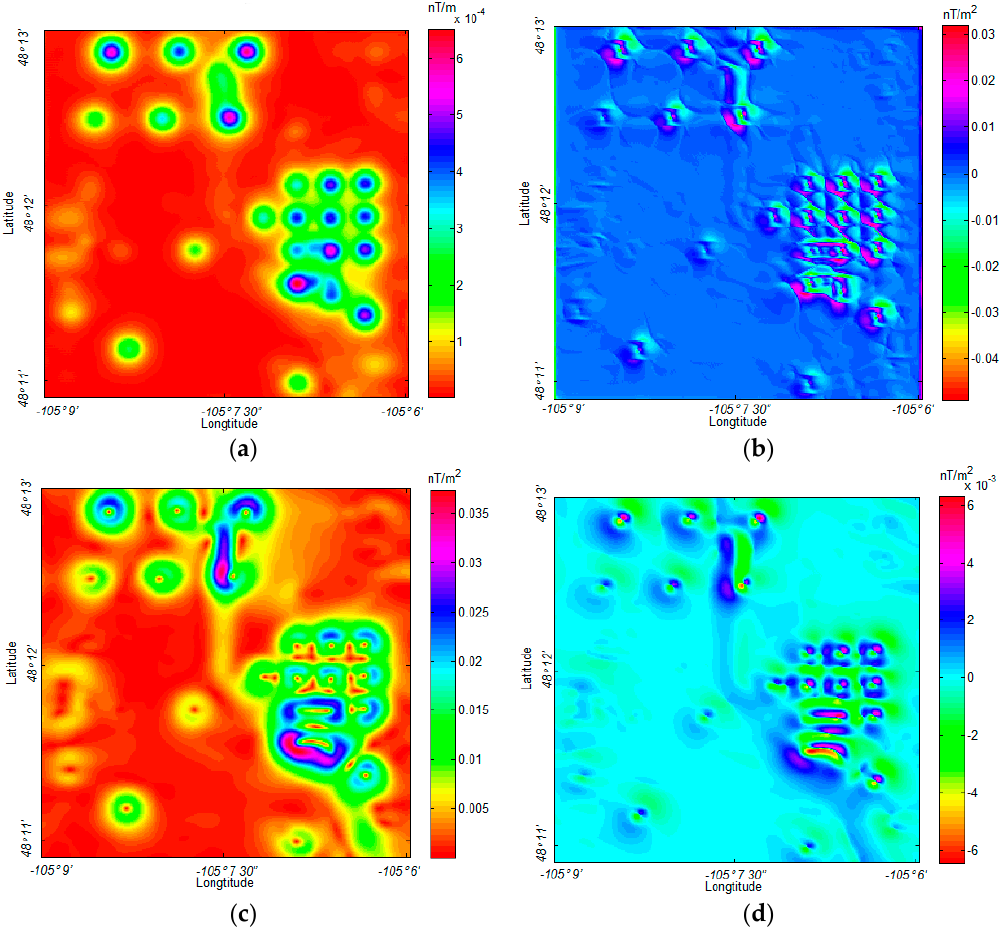
Figure 15. ( a ) NNS of the field data; ( b ) horizontal gradient of ( a ); ( c ) analytic signal of the field data; and, ( d ) horizontal gradient of ( c ).